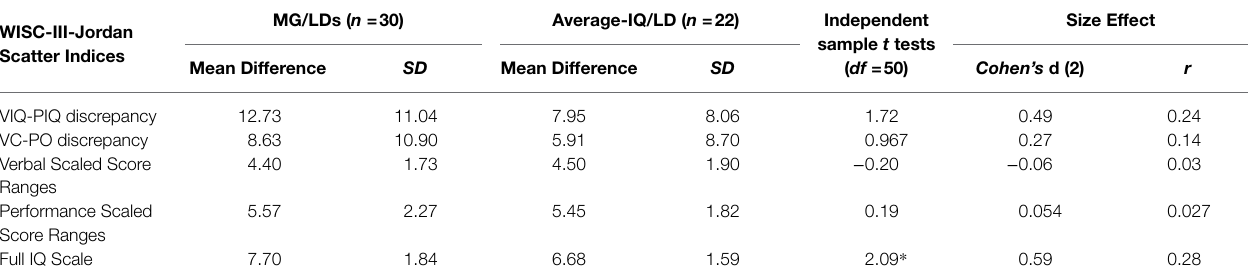
TABLE 1 | WISC-III-Jordan scatter indices within the verbal and performance scales for the MG/LDs and Average-IQ/LD groups. WISC-III-Jordan Scatter Indices